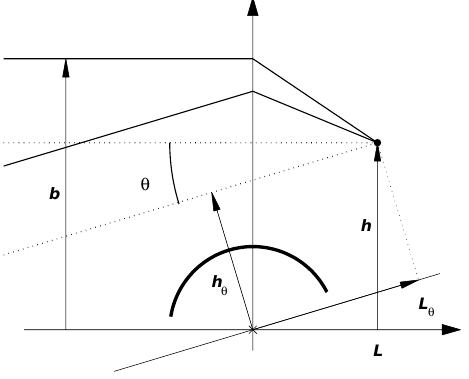
Figure 6. Geometry for angular integration across the solar